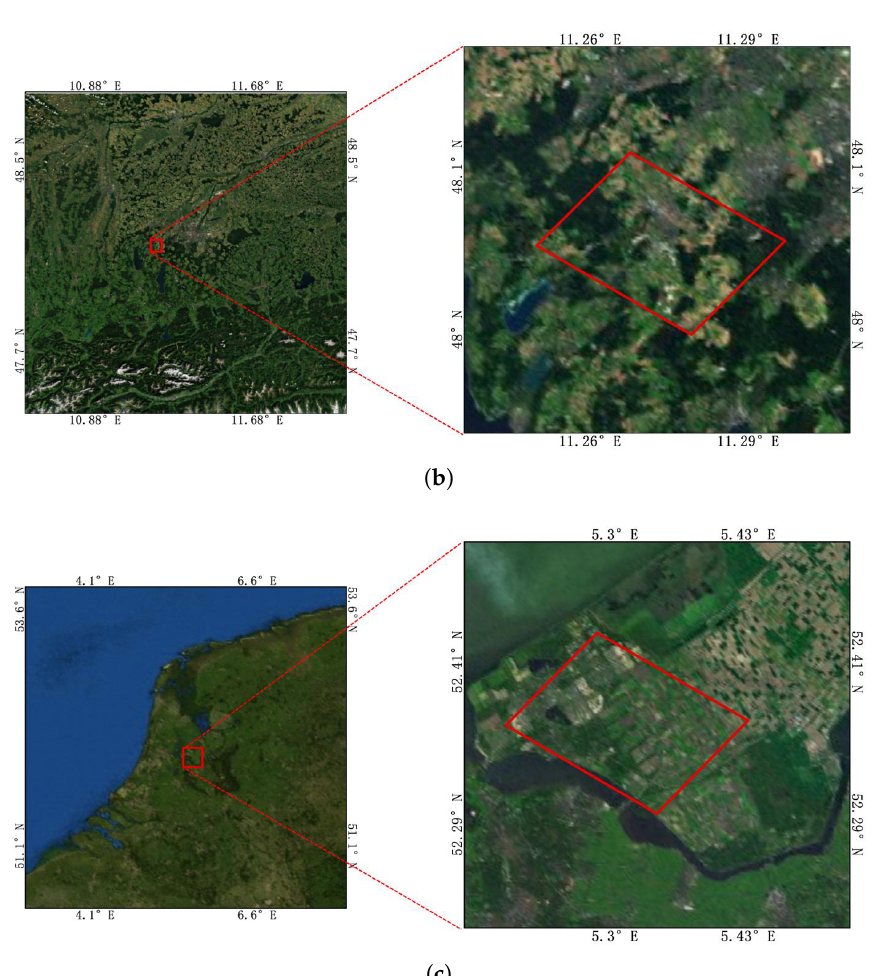
Figure 2. Geographical extent of the two experimental regions. ( a ) The San Francisco region, and the red box in the right picture shows experimental data set 1. ( b ) The Oberpfaffenhofen area in Germany, and the red box in the right picture shows experimental data set 2. ( c ) The Flevoland area in The Netherlands, and the red box in the right picture shows experimental data set